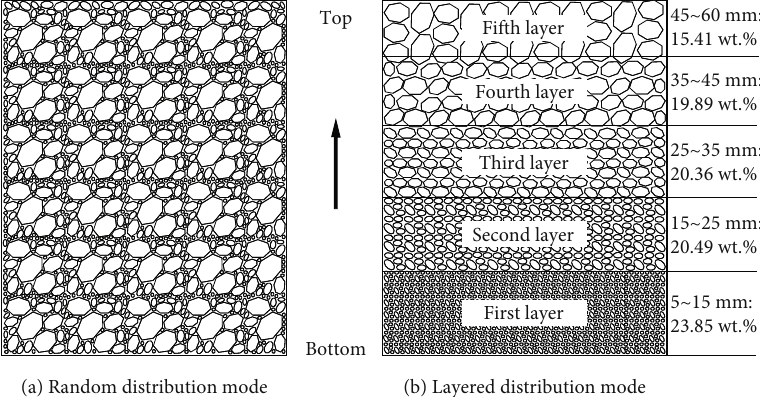
Figure 7: The schematic diagram of the distribution mode: (a) the random distribution mode; (b) the fi ve-layer arrangement mode with the particle size increasing from the bottom-up (i.e., mode 1 in Table